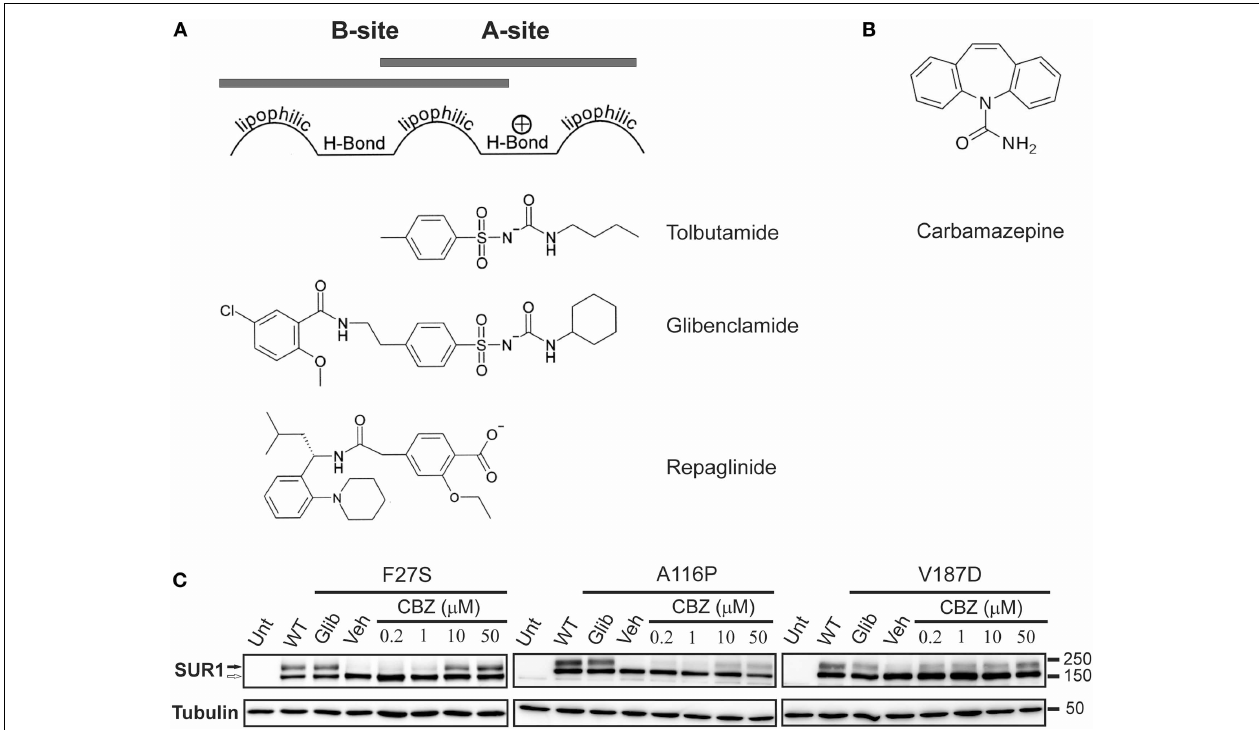
FIGURE 3 | The processing defect of SUR1 caused by TMD0 trafficking mutations is corrected by glibenclamide and carbamazepine. (A) Pharmacophore model for binding of various K ATP channel blockers that function as effective pharmacological chaperones, showing the chemical moieties thought to confer affinity for either site A or site B on SUR1. (B) Chemical structure of carbamazepine. (C) Western blot of whole cell lysates of COSm6 cells transiently transfected with Kir6.2 plus WT or TMD0 mutant SUR1 cDNAs. SUR1, a glycoprotein, shows two bands in